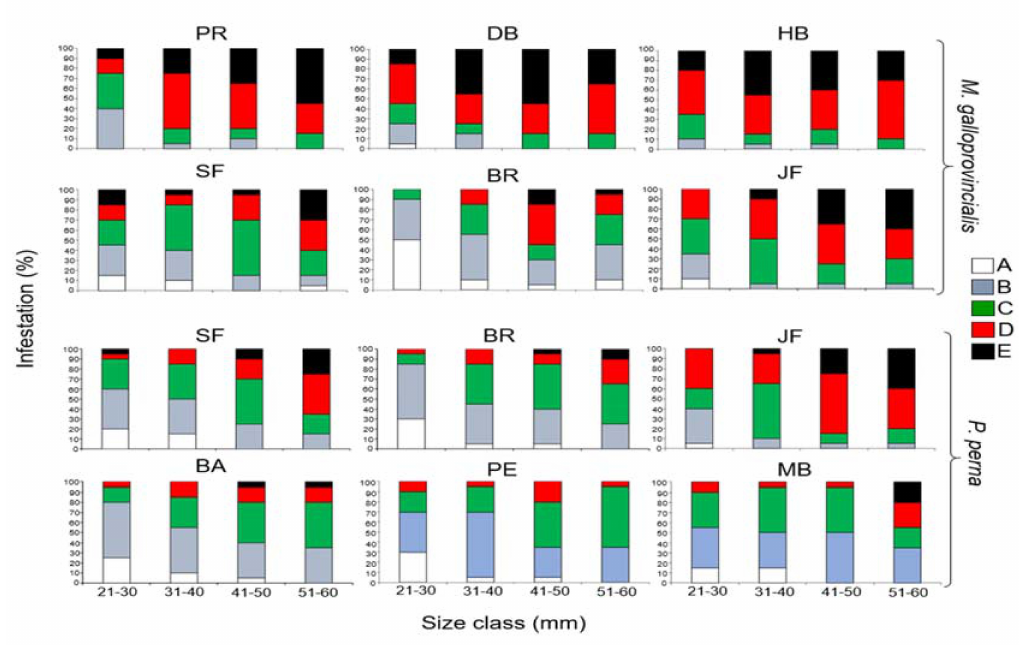
Figure 2. Prevalence of infestation (%) of mussel shells categorised by degrees of infestation severity for each site (Groups / levels A–E), grouped into 10 mm size classes for all three bioregions in South